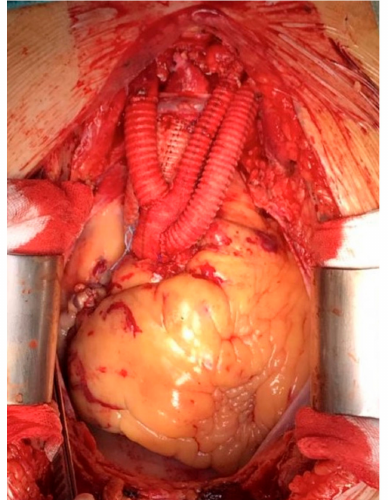
Figure 3. Type II aortic arch